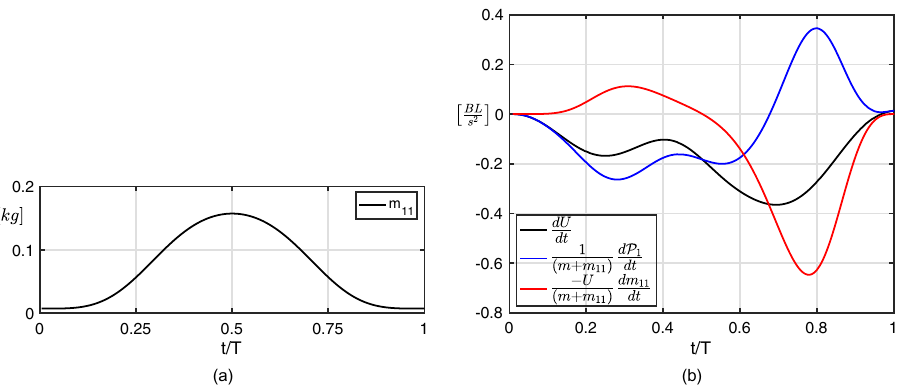
Figure 4. Time history of ( a ) the added mass coefficient m 11 and of ( b ) the forward acceleration contributions for the C-start maneuver.